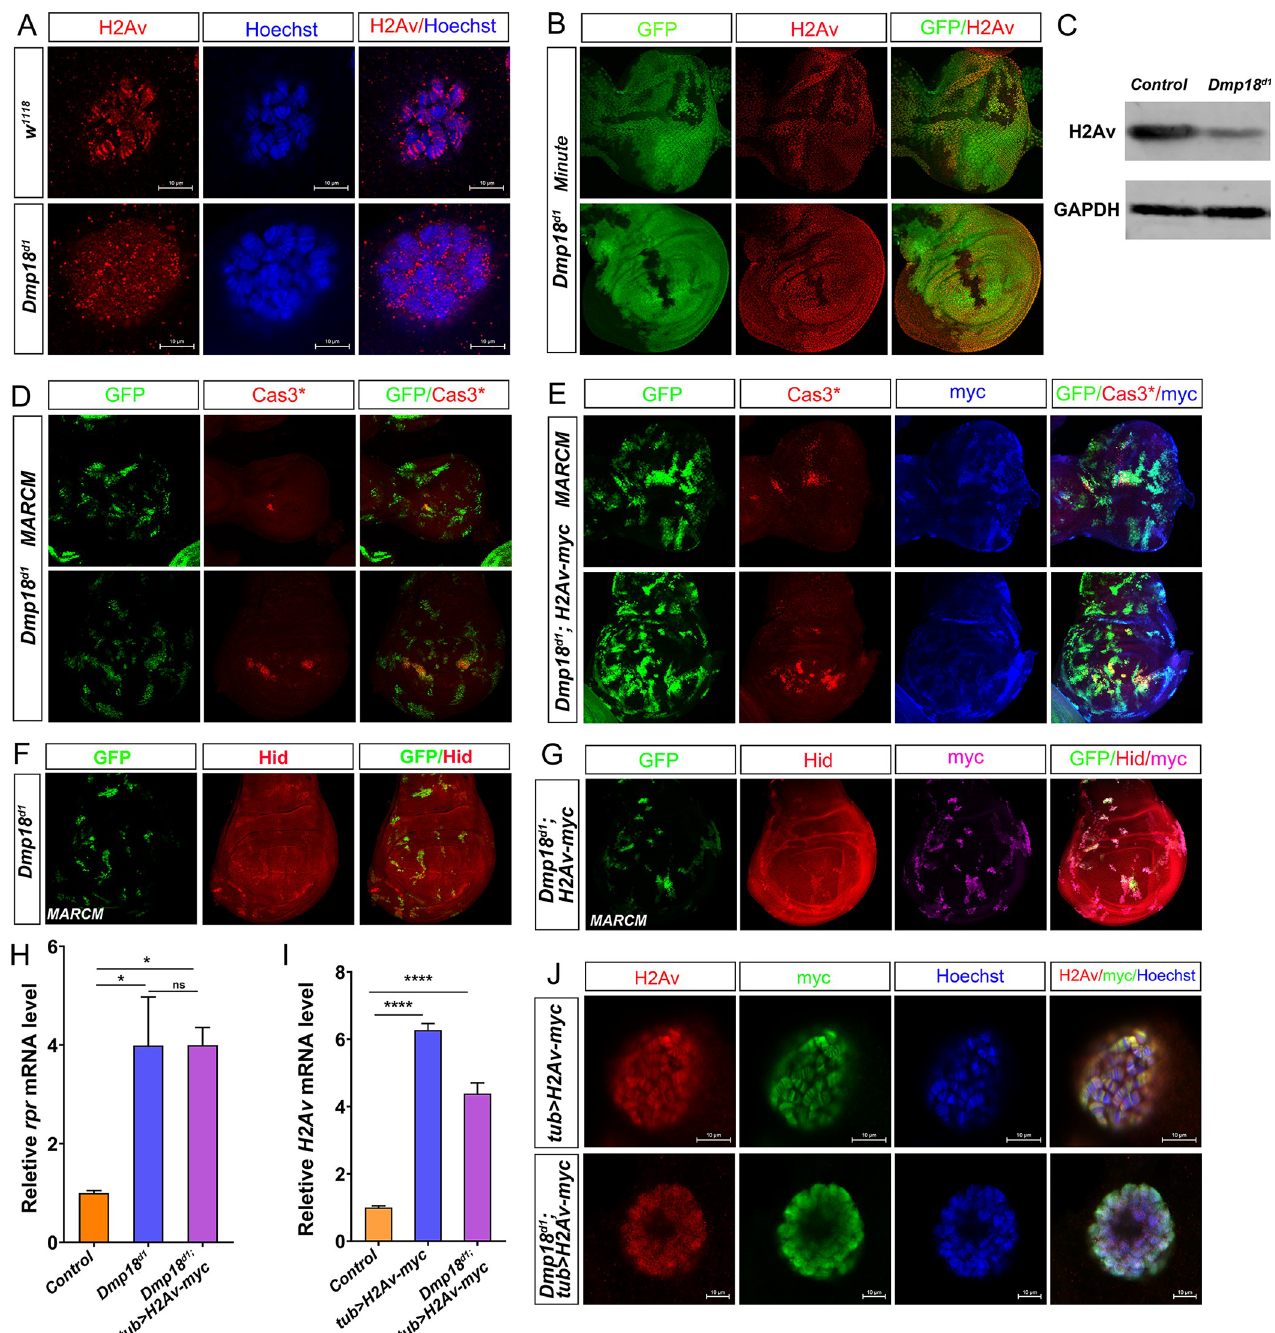
Fig 7. Dmp18 regulates apoptosis by mediating H2Av incorporation. (A) Loss of Dmp18 disrupted incorporation of H2Av into chromatin. (B) The protein level of H2Av was reduced in the Dmp18 mutant clones in the eye and wing discs. GFP-free region marked the Dmp18 mutant clones. (C) The whole larvae were used for immunoblotting with the H2Av antibody. The protein level of H2Av was reduced in the homozygous Dmp18 d1 . The GAPDH worked as the loading control. (D) Loss of Dmp18 activated Cas3 � in the eye and wing discs. (E) Over-expression of H2Av-myc did not inhibit Cas3 � activity in the Dmp18 mutant clones. (F) Loss of Dmp18 up-regulated Hid expression. (G) Over-expression of H2Av-myc did not reduce the Hid expression in the Dmp18 mutant clones. D-G: GFP marked the Dmp18 mutant clones or Dmp18 mutant clones with over-expressed H2Av-myc. (H) The RT-qPCR analysis showed the transcription level of rpr in the control, homozygous Dmp18 d1 and homozygous Dmp18 d1 with over-expressed H2Av-myc. The rpr still showed high expression when H2Av-myc was over-expressed in the homozygous Dmp18 d1 . (I) The RT-qPCR analysis showed the transcription of H2Av in control, H2Av-myc and homozygous Dmp18 d1 with over-expressed H2Av-myc. (J) H2Av-myc driven by tub-gal4 was deposited on chromatin and co-localized with endogenous H2Av well in the wild-type, but it failed to be deposited on chromatin in the homozygous Dmp18 d1 . � p < 0.05 and ���� p < 0.0001. Genotypes: A: w 1118 and FRT 40A -